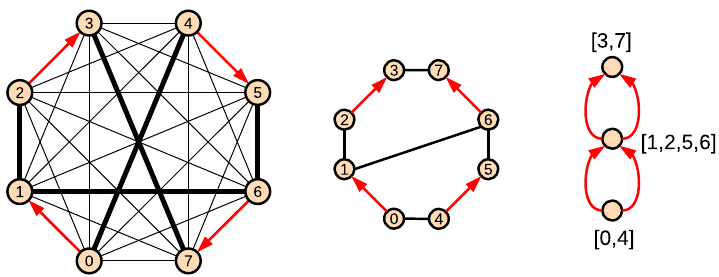
Figure 5. From left to right: A spanning mixed subgraph H of G 8 (represented over G 8 to remark the subgraph condition), H represented alone and its associated digraph. Partition associated to H is { [ 0,4 ] , [ 1,2,5,6 ] , [ 3,7 ] } .